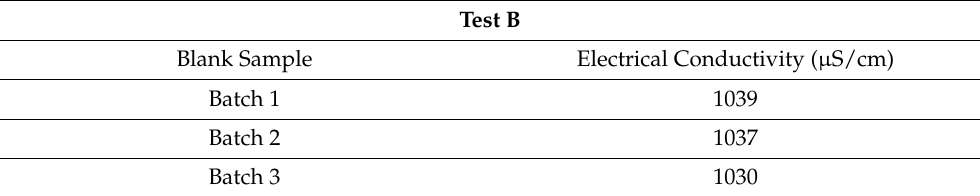
Table 5. Electrical conductivity values for blank samples in Test